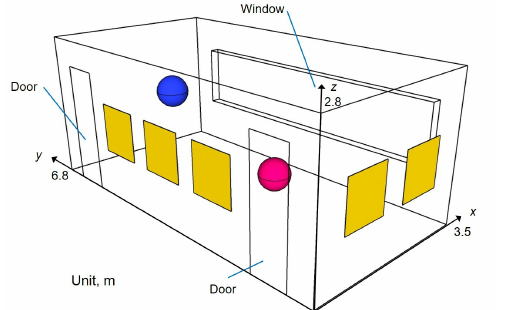
Figure 1. Problem 1 for scalability test: a meeting room model. Blue and magenta spheres respectively represent the source point and the receiving point.